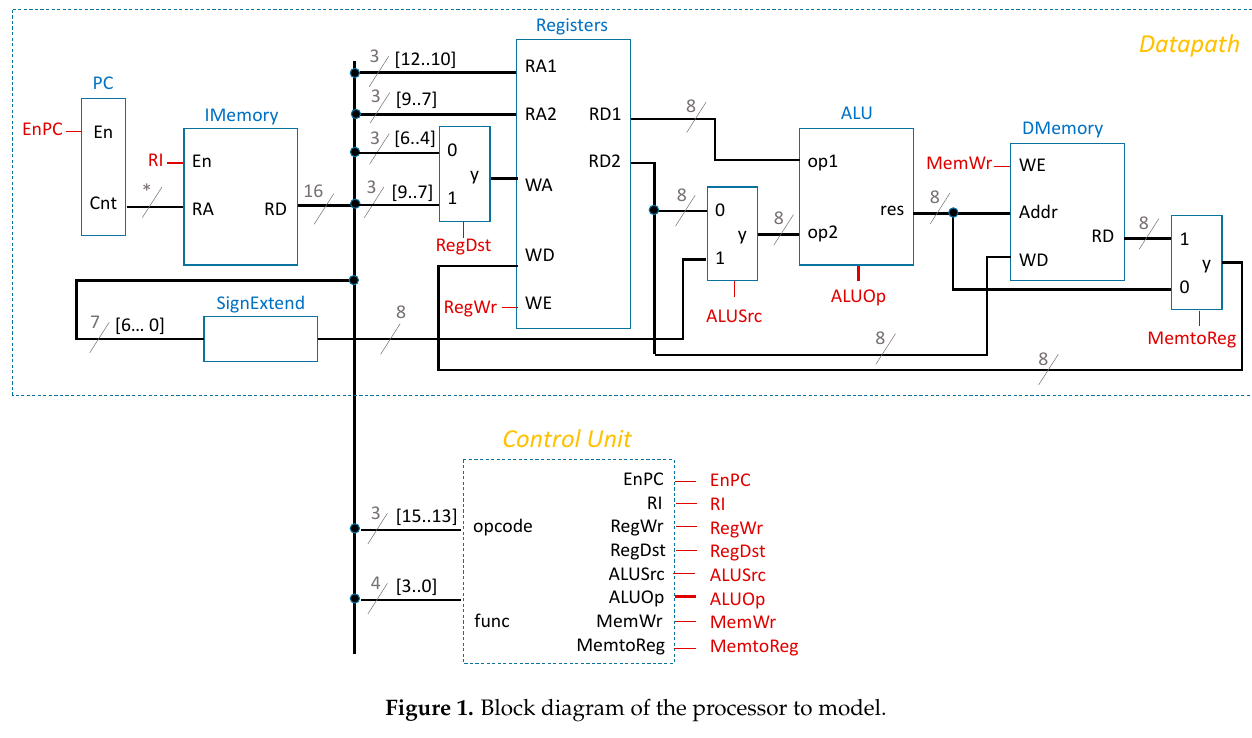
Figure 1. Block diagram of the processor to model.